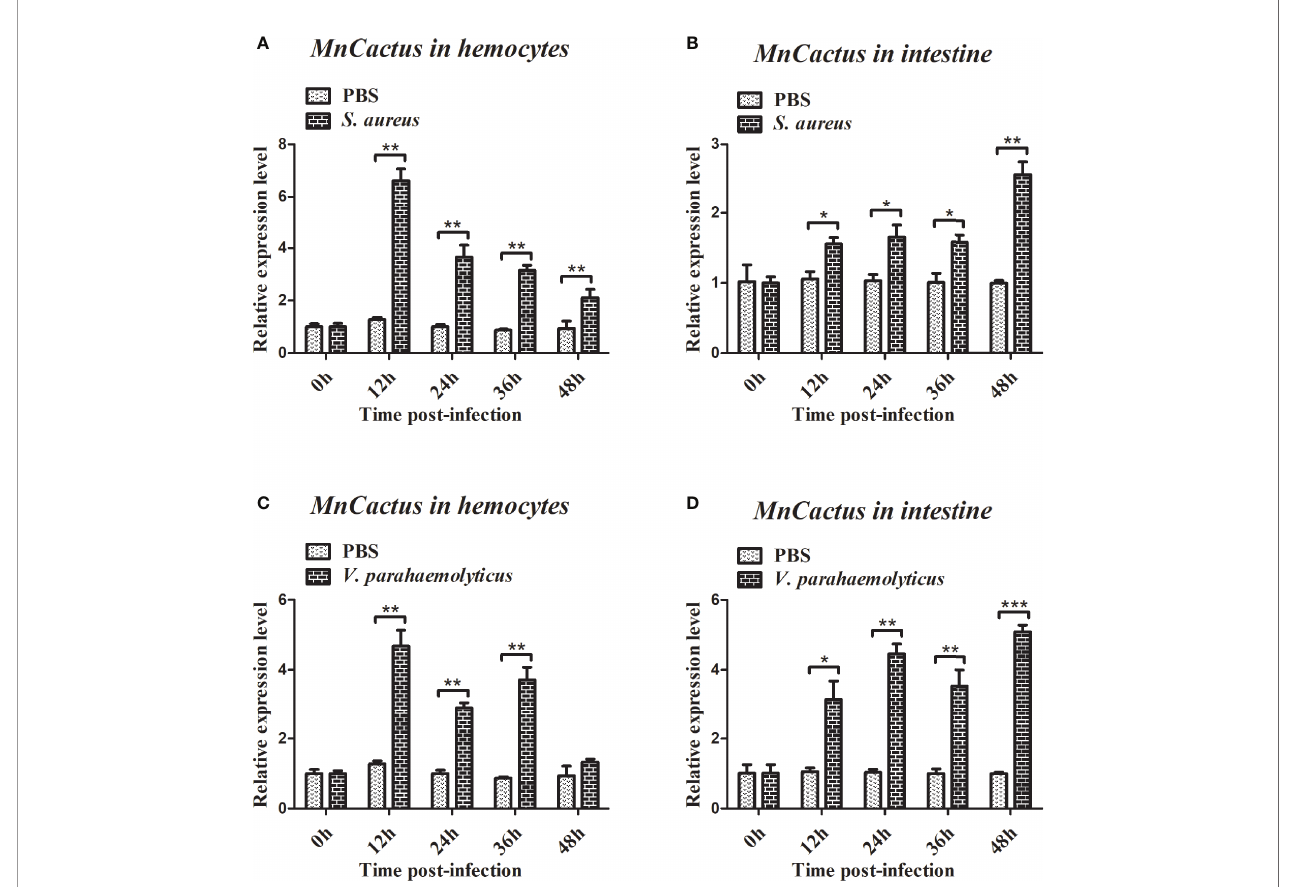
FIGURE 5 | Relative transcription levels of MnCactus in the hemocytes and intestines of bacterial-infected prawns. At 0, 12, 24, 36, and 48 h after S. aureus (A, B) or V. parahaemolyticus (C, D) infection in prawns, hemocytes and intestines were collected and processed for the RT-qPCR analysis of MnCactus expression. b - actin was used as an internal control. Data are presented as mean ± SD, N = 5. Signi fi cance was compared between the experimental group and the PBS-injected group at the same time point. Signi fi cant differences are indicated with an asterisk at P < 0.05, two asterisks at P < 0.01 or three asterisks at P <